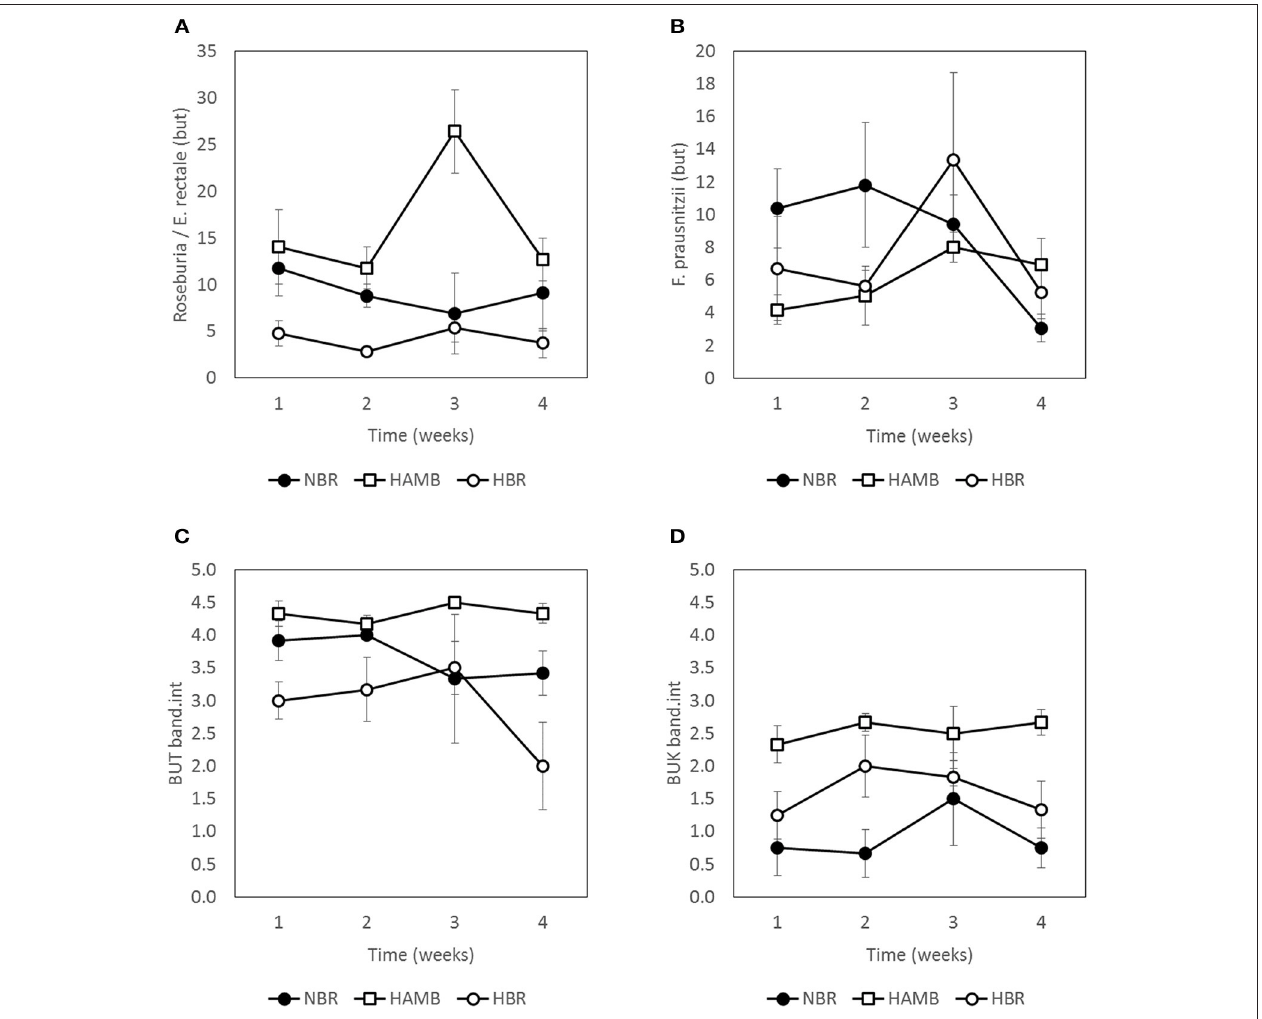
FIGURE 8 | Abundance of butyrate producing community members as estimated by two approaches, qPCR (A,B), and band intensities (C,D) during run-in (week 1) and subsequent 3-week experimental phase. Units are scaled to represent % of total bacterial microbial community (A,B) . Band intensities of PCR products (C,D) were categorized according to band intensity classes (0–5) ( Vital et al.,